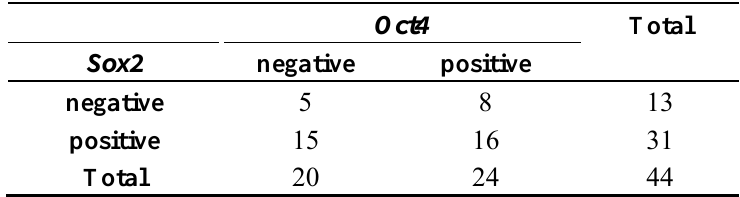
Table 3. Sox2 and Oct4 expression cross tabulation.